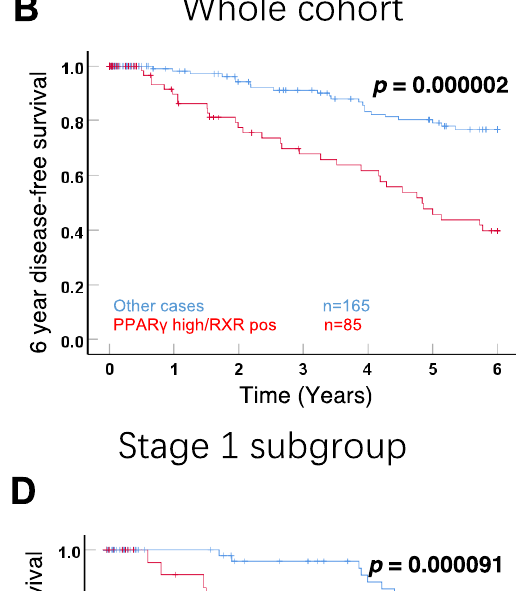
Table 2. Correlations of d ouble cytoplasmic staining (RXRα positive/PPARγ high) with clinical parameters in the whole cohort of 250 BC patients.